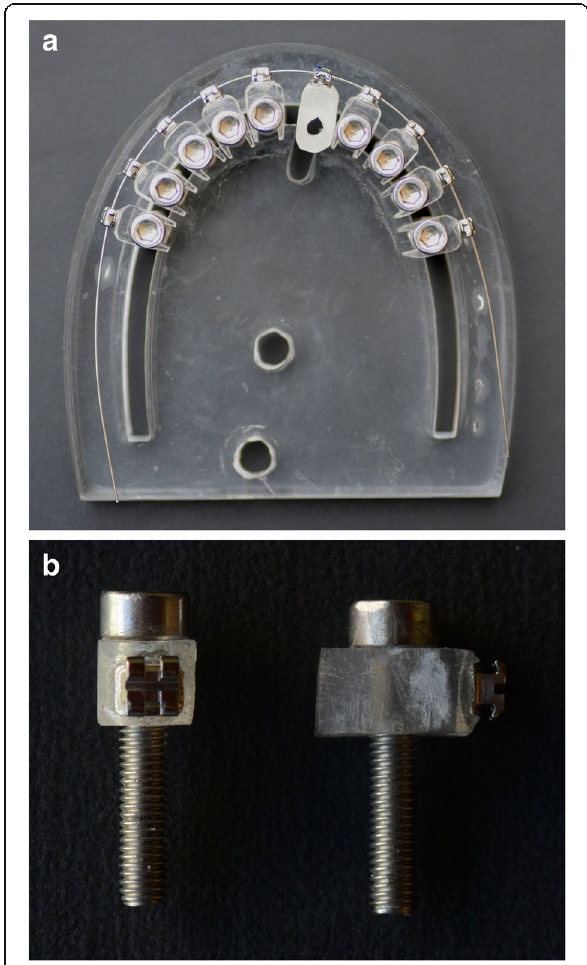
Fig. 1 a The clinical simulation device used in this study. b Block representative of the teeth attached to the